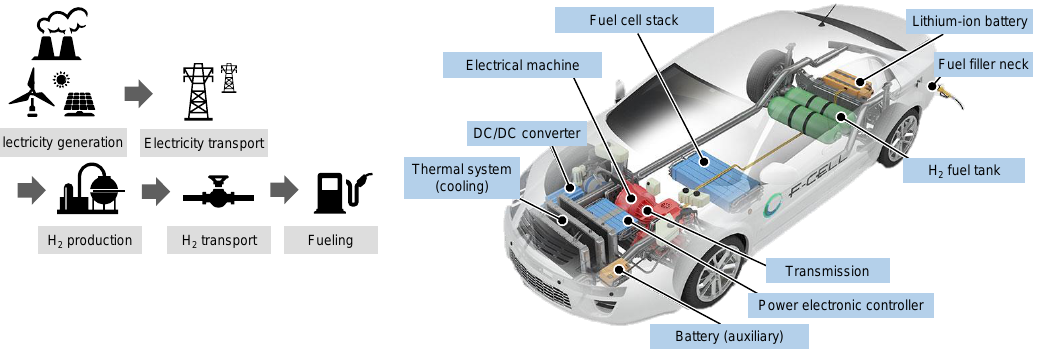
Figure 3. Components of FCEV powertrains acc. [11].